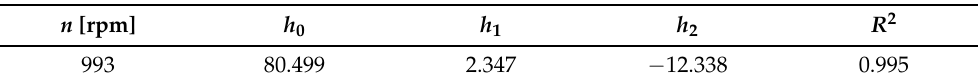
Table 7. The coefficients of the 2nd-degree polynomial approximation function for the pumping head H = f ( Q ) of the 1MW Worthington pump at speed of 993 rpm.